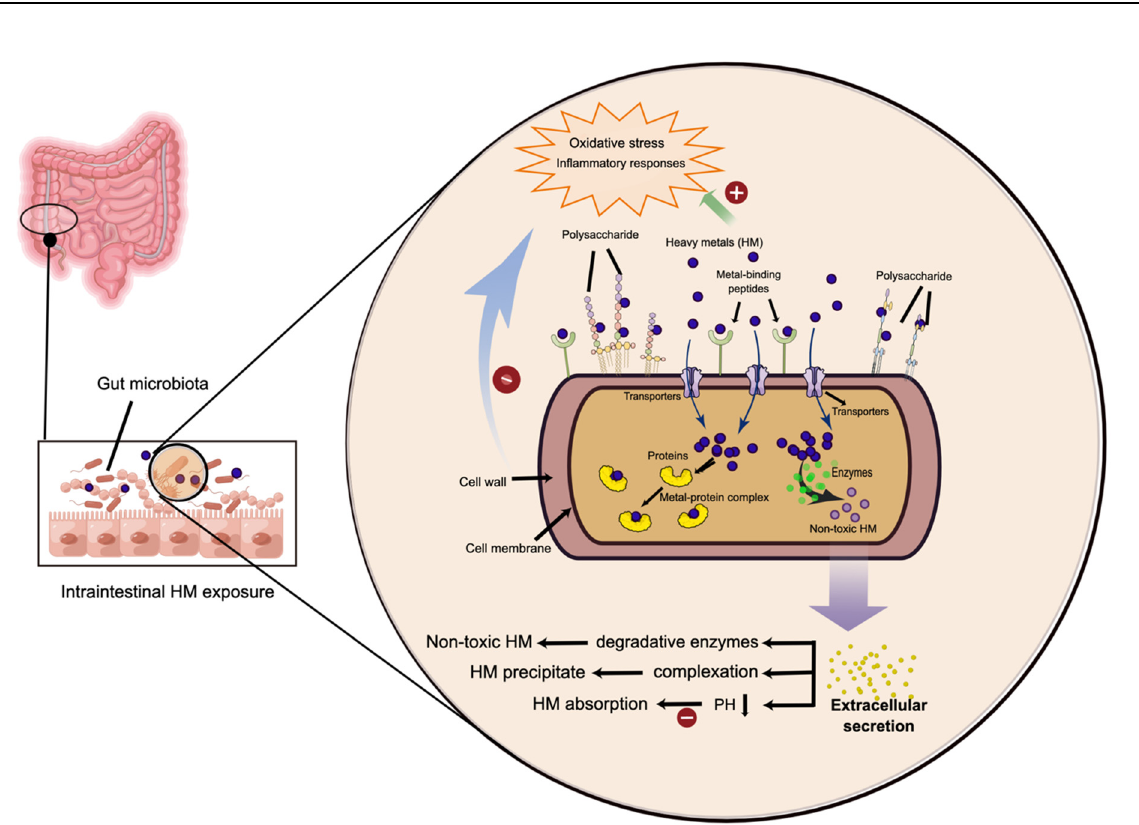
Figure 1. The underlying mechanisms of heavy metal (HM) detoxification by probiotics. (1) Cell wall binding sites for HMs: bacterial cell walls contain different polysaccharides and HM-binding proteins that serve as potential binding or biosorption sites for metal ions. (2) Intracellular seques- tration of HMs: metal ions enter the cytoplasm by active transportation or passive diffusion via transporters, then bind with the intracellular metal-chelating proteins to form protein–metal complex or transformed into nontoxic forms undergoing enzymatic reactions. (3) Extracellular secretion for HM detoxification: various substances or molecules can be secreted by probiotics for three purposes: convert HM into less toxic/adsorbable forms; form complex-precipitation with HMs; decrease intestinal PH and subsequently inhibit the HM absorption into epithelial cells. (4) Counteraction of the HM-induced oxidative stress and inflammatory responses. By Figdraw (www.figdraw.com accessed on 26 March 2022). Table 2. Heavy metal detoxification by probiotics and their possible mechanisms.